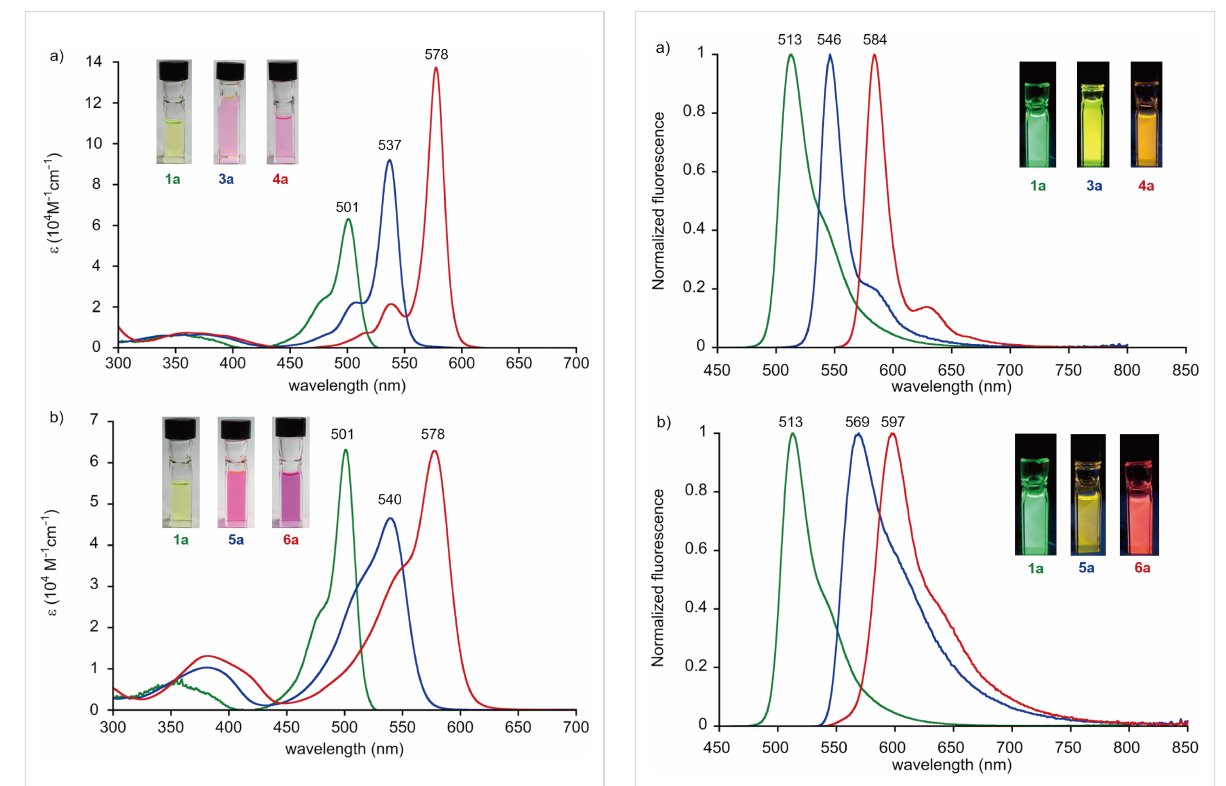
Figure 5: Fluorescence spectra of BODIPY derivatives. (a) 1a (green), 3a (blue), 4a (red) and (b) 1a (green), 5a (blue), and 6a (red) in CH 2 Cl 2 . Excitation was performed at 365 nm. The insets show the photo images of the solution under a UV lamp.